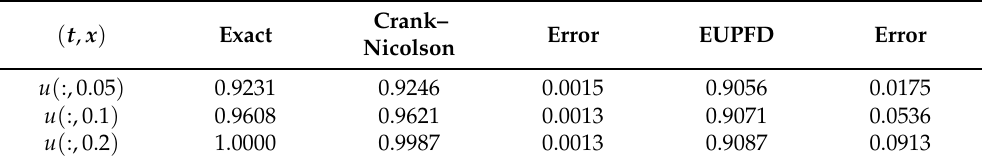
Table 4. Infinity norm results of the linear ADR equation by using the exact, Crank Nicolson, and EUPFD